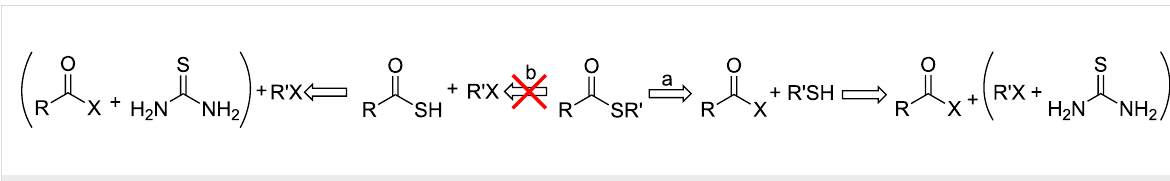
Scheme 1: One-pot procedure for the preparation of thioesters.